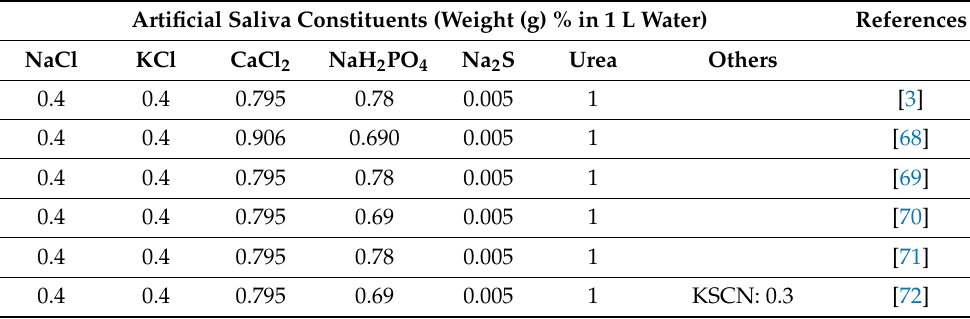
Table 1. General artificial saliva compositions used in previous